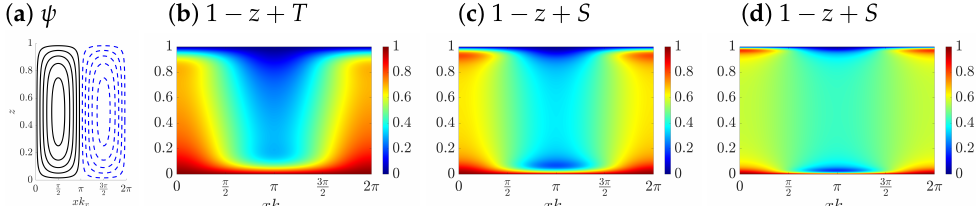
Figure 6. Solution profile of single-mode solutions displaying isocontours of ( a ) streamfunction ψ , ( b ) total temperature 1 − z + T and ( c ) total salinity 1 − z + S at Ra T = 200, k x = 1.89 π , and Le = 4. Panel ( d ) shows the isocontours of total salinity 1 − z + S at Le = 20 with other parameters unchanged. This figure is to be compared with the corresponding DNS results (Figure 5 in